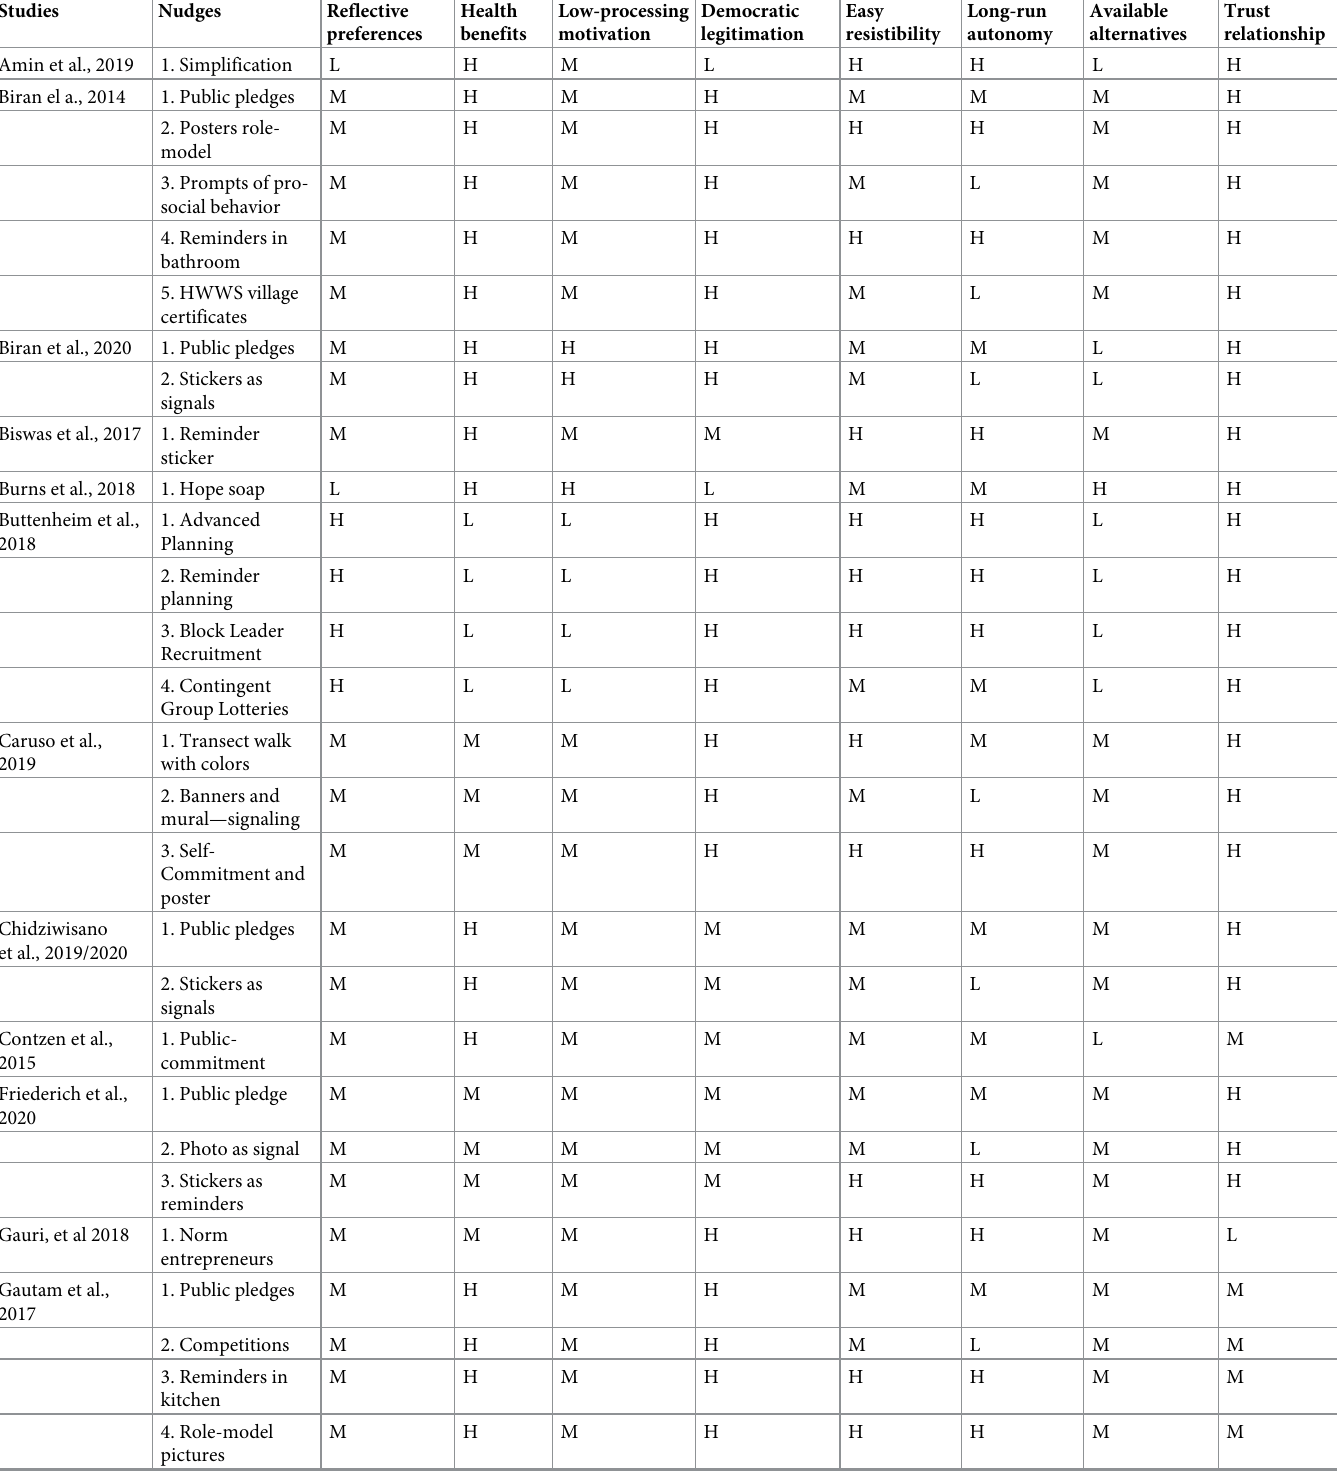
Table 4. The ethical assessment of the included nudge strategies targeting health promotion behaviors related to neglected tropical diseases in low- and middle- income countries. Studies Nudges Reflective Health preferences